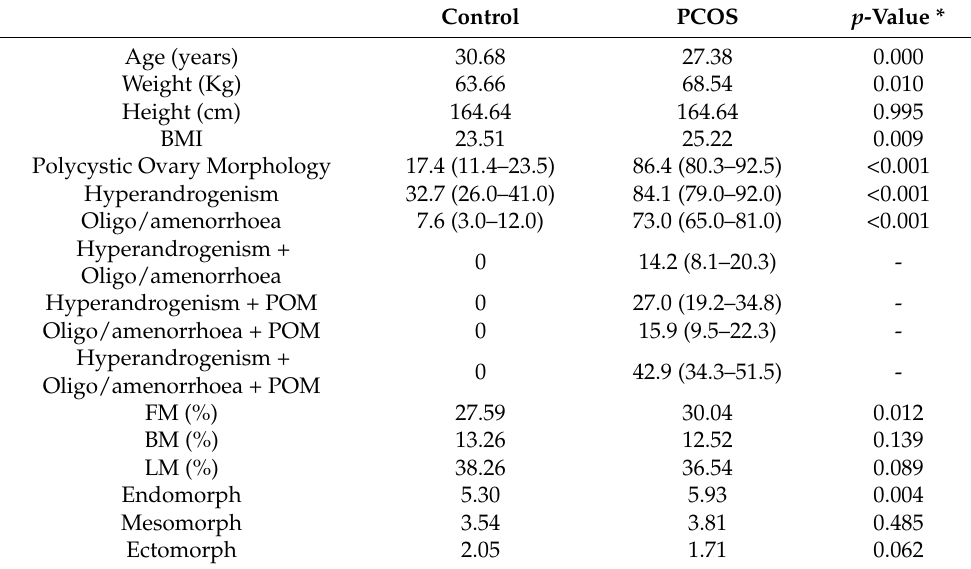
Table 1. Anthropometric measurements and analytical determinations in PCOS and control